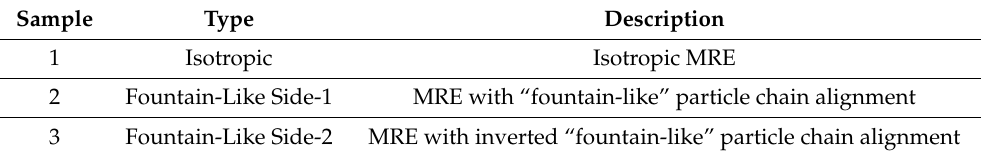
Table 2. Types of MRE samples.